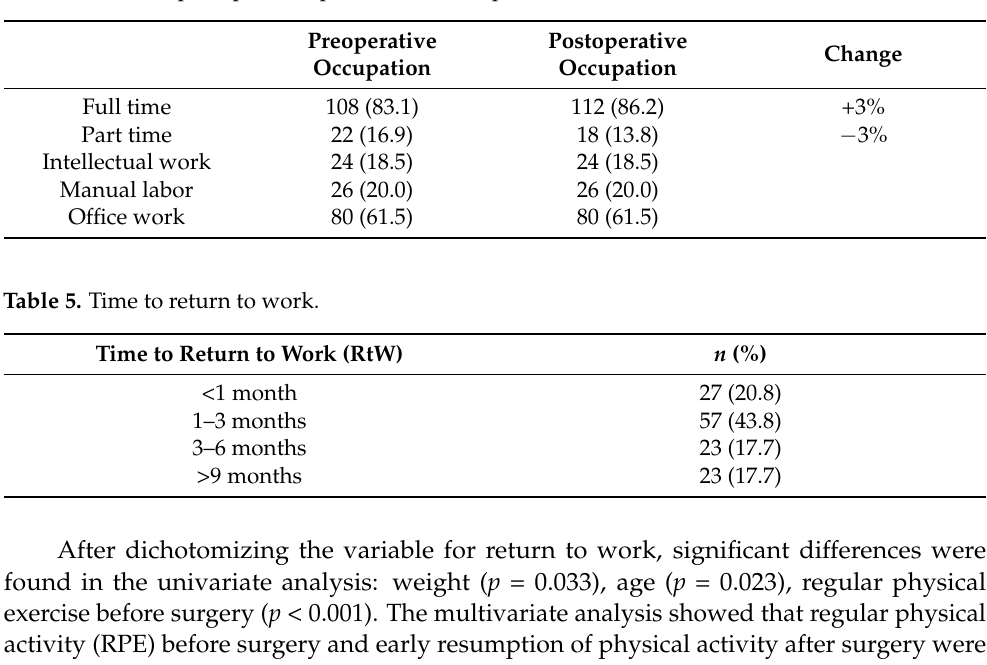
Table 4. Pre- and postoperative professional occupation.